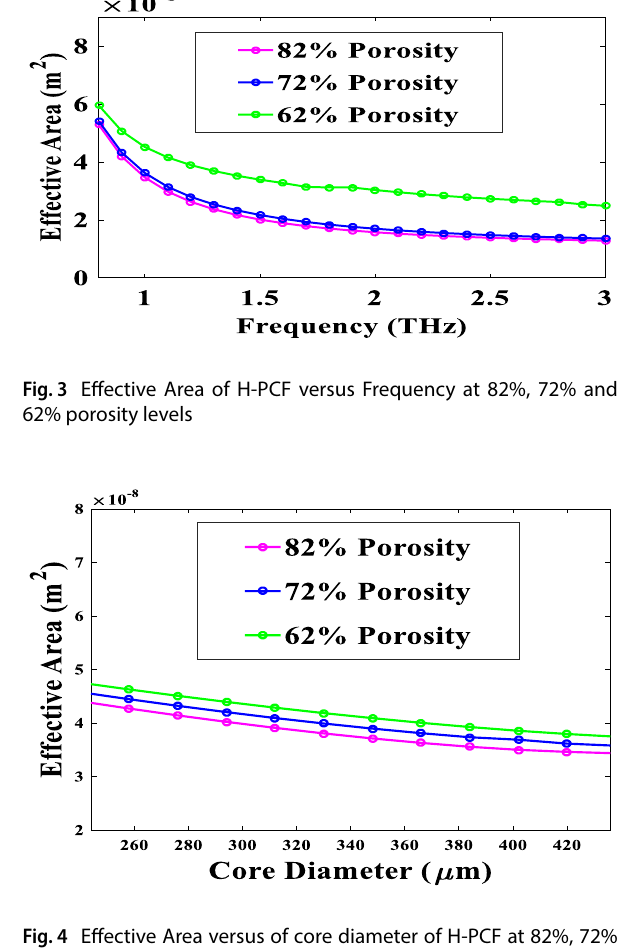
Fig. 4 Effective Area versus of core diameter of H-PCF at 82%, 72% and 62% porosity levels